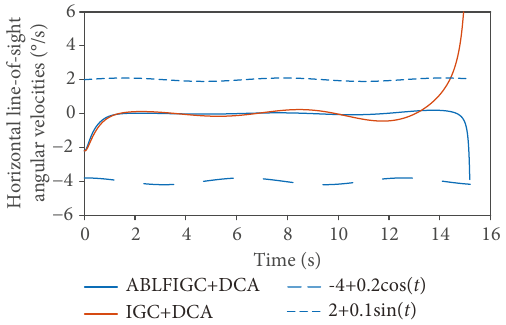
Figure 19: Curves of angular velocities of horizontal line of sight of the interceptor missile in Scenario 1: ABLFIGC+DCA refers to a combination of the proposed asymmetric barrier Lyapunov function-based IGC algorithm and the dynamic control allocation algorithm; IGC+DCA refers to a combination of the IGC algorithm subject to the traditional dynamic surface sliding-mode control law and the dynamic control allocation algorithm.